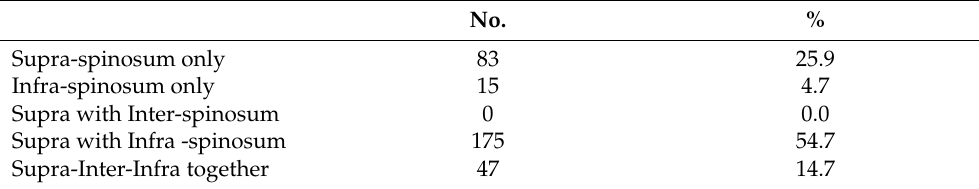
Table 1. Distribution of the studied cases according to supra, inter, and infra-spinosum ( n = 320). No. % Supra-spinosum only 83 25.9 Infra-spinosum only 15 4.7 Supra with Inter-spinosum 0 0.0 Supra with Infra -spinosum 175 54.7 Supra-Inter-Infra together 47